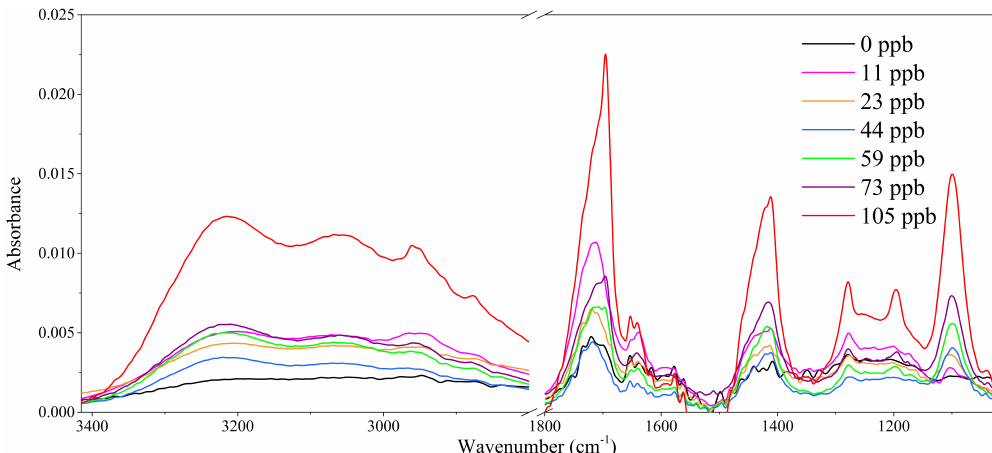
Figure 4. IR spectra of aerosols from the cyclohexene / NO x / SO 2 system under different SO 2